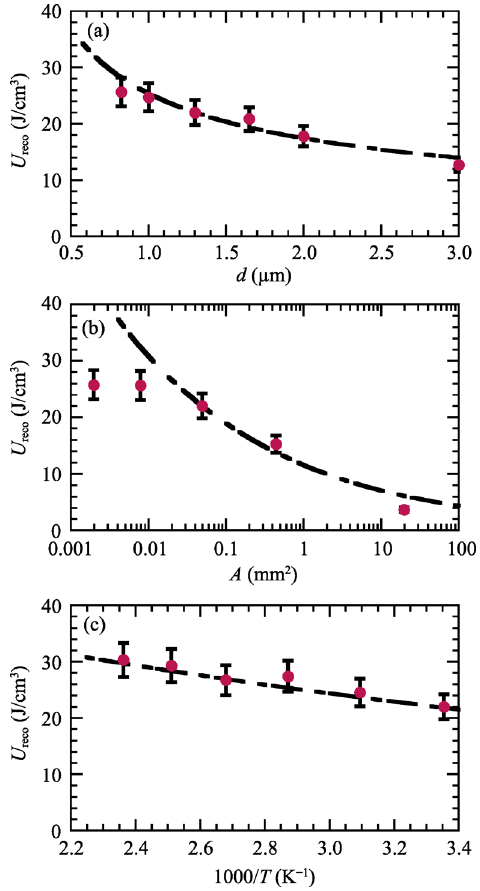
Fig. 5 Recoverable electric energy density ( U reco ) of PLZT films as function of film thickness (a), electrode area (b), and temperature